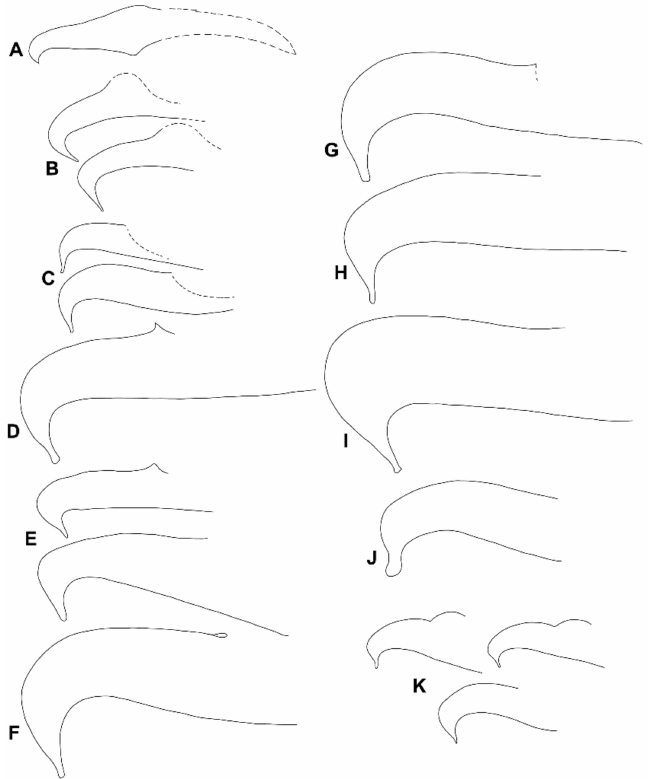
Figure 9. Different aedeagus shapes of Oligonychus mangiferus; ( A ) redrawn from original descrip- tion [9], and redrawn from various redescriptions; ( B ) [14], ( C ) [4], ( D ) [5], ( E ) [7], ( F ) [5], ( G ) [3],